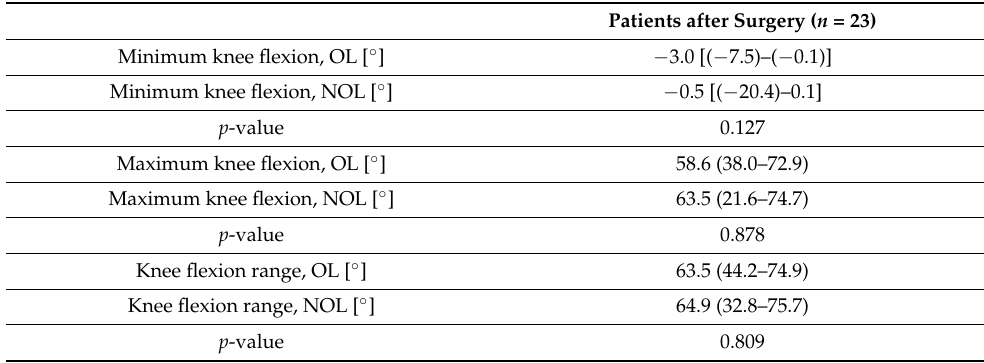
Table 2. Differences in knee flexion after Ilizarov therapy.